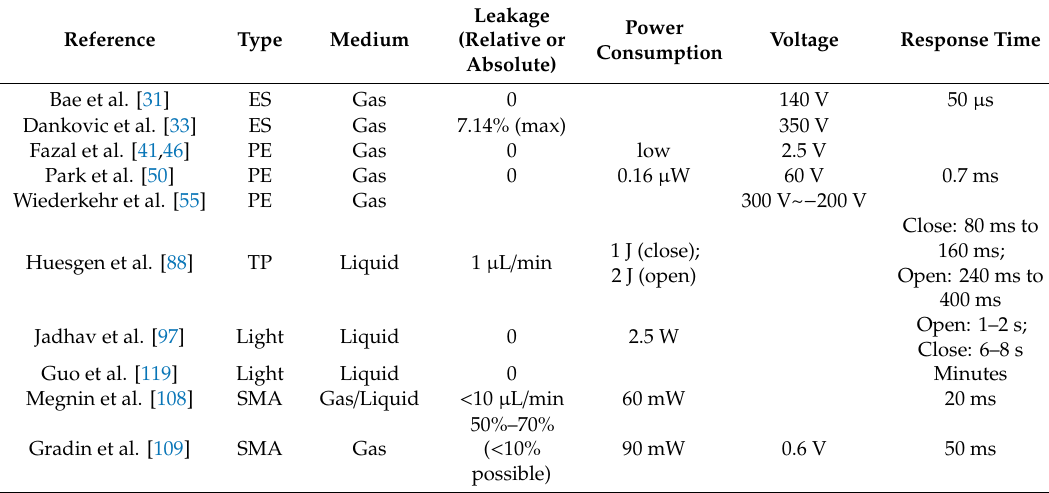
Table 7. Comparison of typical high flow microvalves.